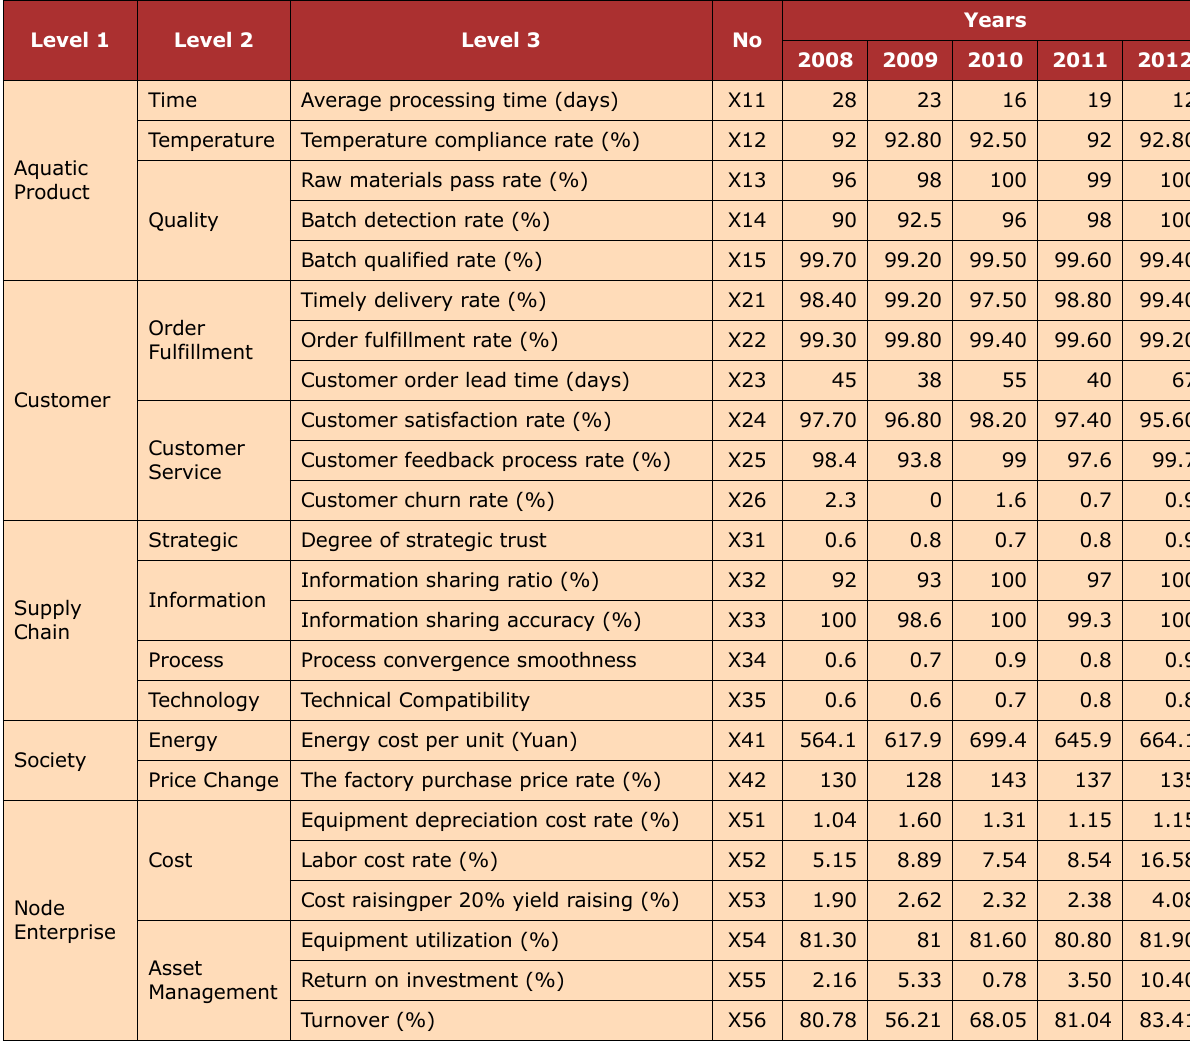
Table 1. The evaluation indexes and the operation data of the example